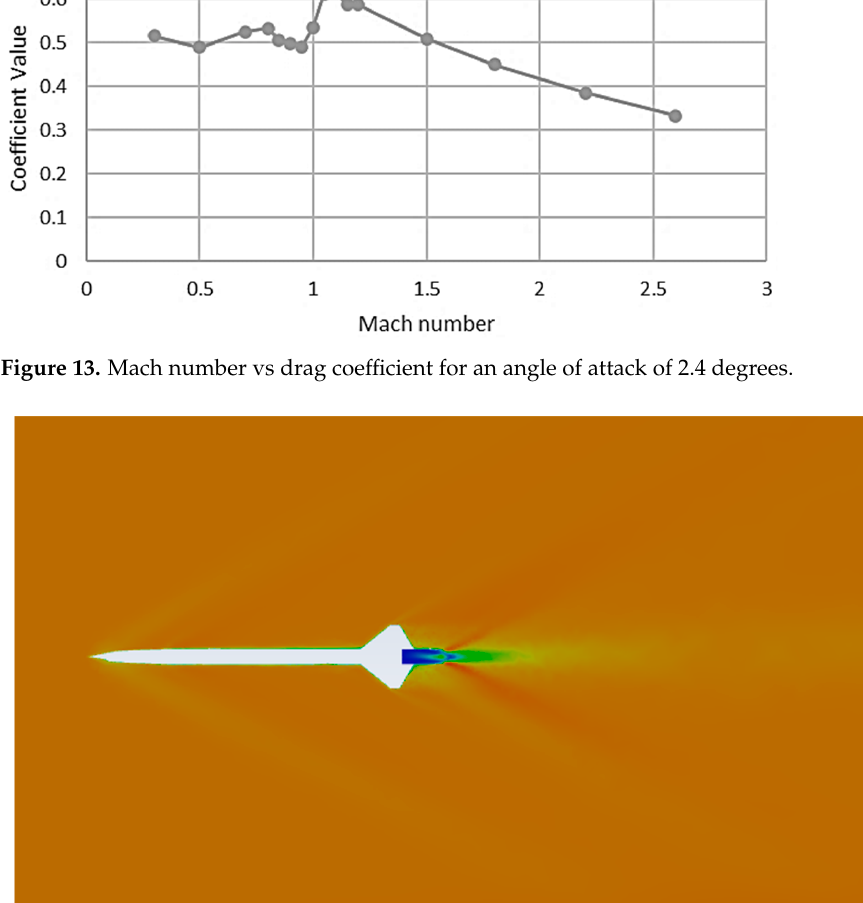
Figure 14. Contours of the Mach number at 2.4-degree AoA and 2.2 Mach.